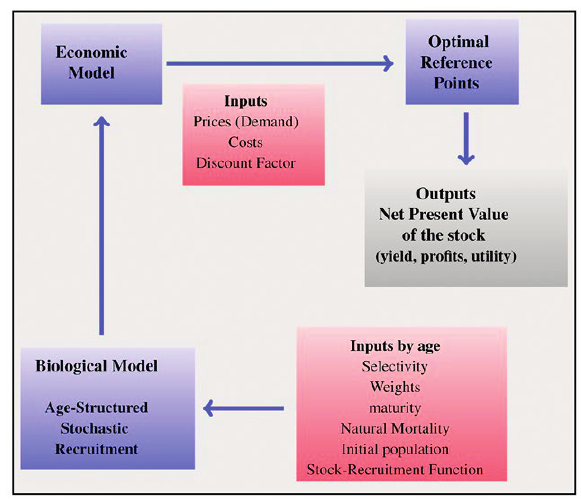
Fig. 2. – Optimal reference points within the SASOM